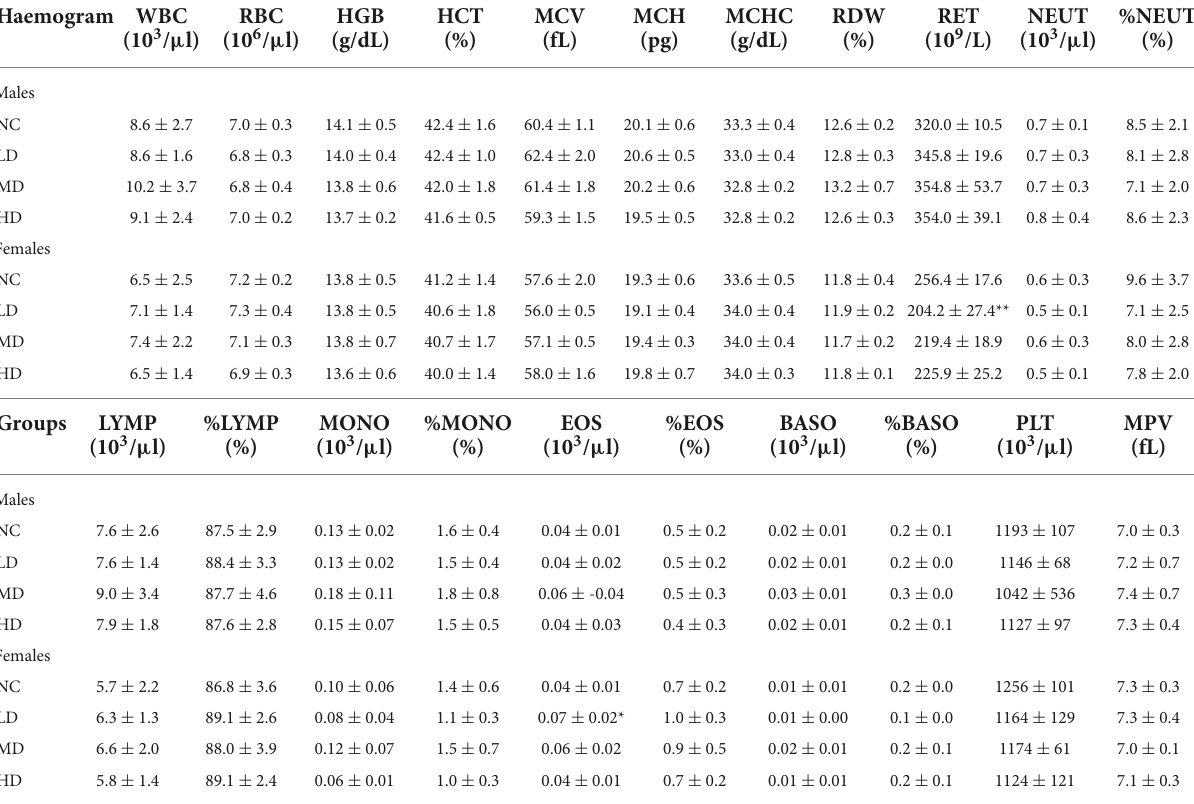
TABLE 2 Effects of aqueous extracts of Cyclocarya paliurus leaves on the hematology of Sprague-Dawley (SD) rats in the acute toxicity